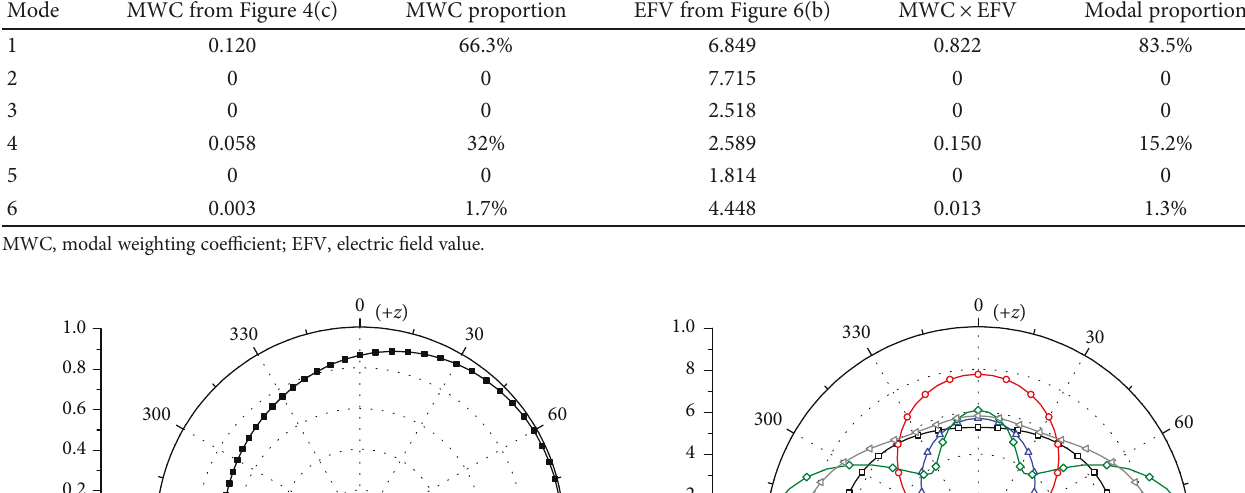
Table 1: MWCs and far fi eld values ( θ = 340 ° and φ = 90 ° ) of the fi rst 6 modes of CCE-fed antenna at 2.2 GHz. Mode MWC from Figure